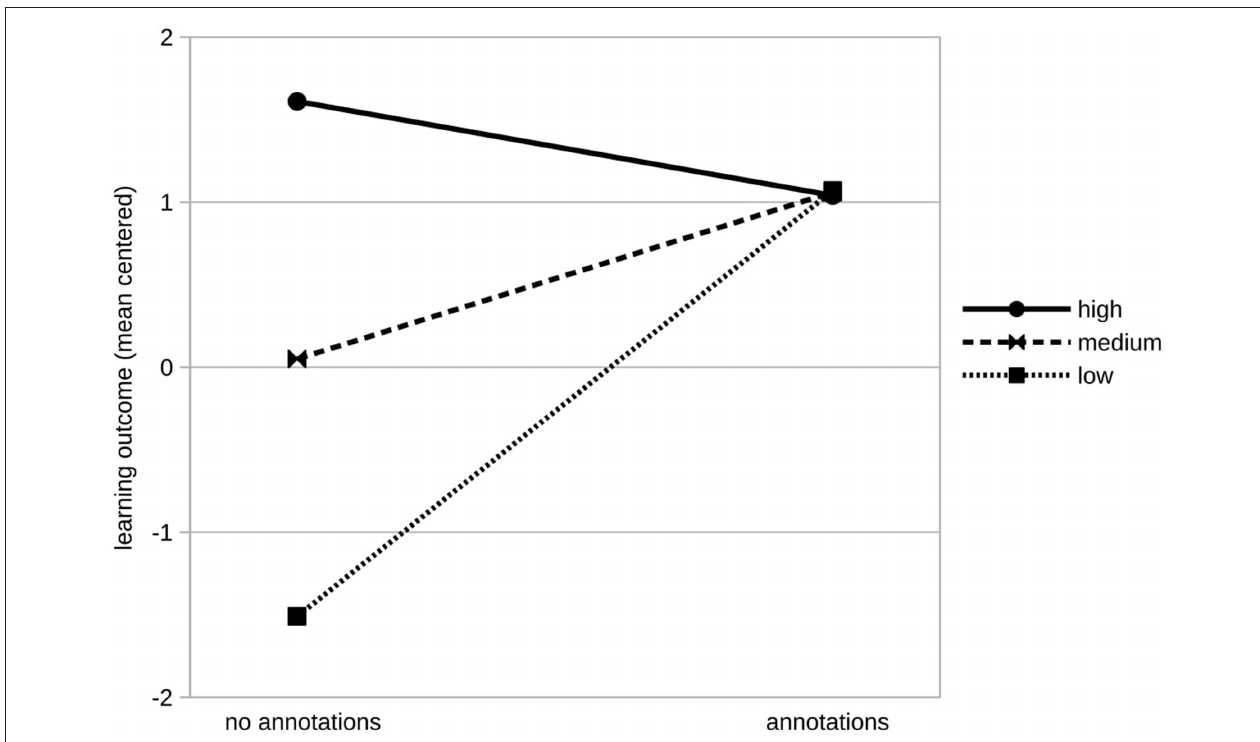
FIGURE 3 | Learning outcome dependent on learners’ intrinsic motivation (“low:” one standard deviation below the mean, “medium:” at the mean, and “high” one standard deviation above the mean) and experimental condition.